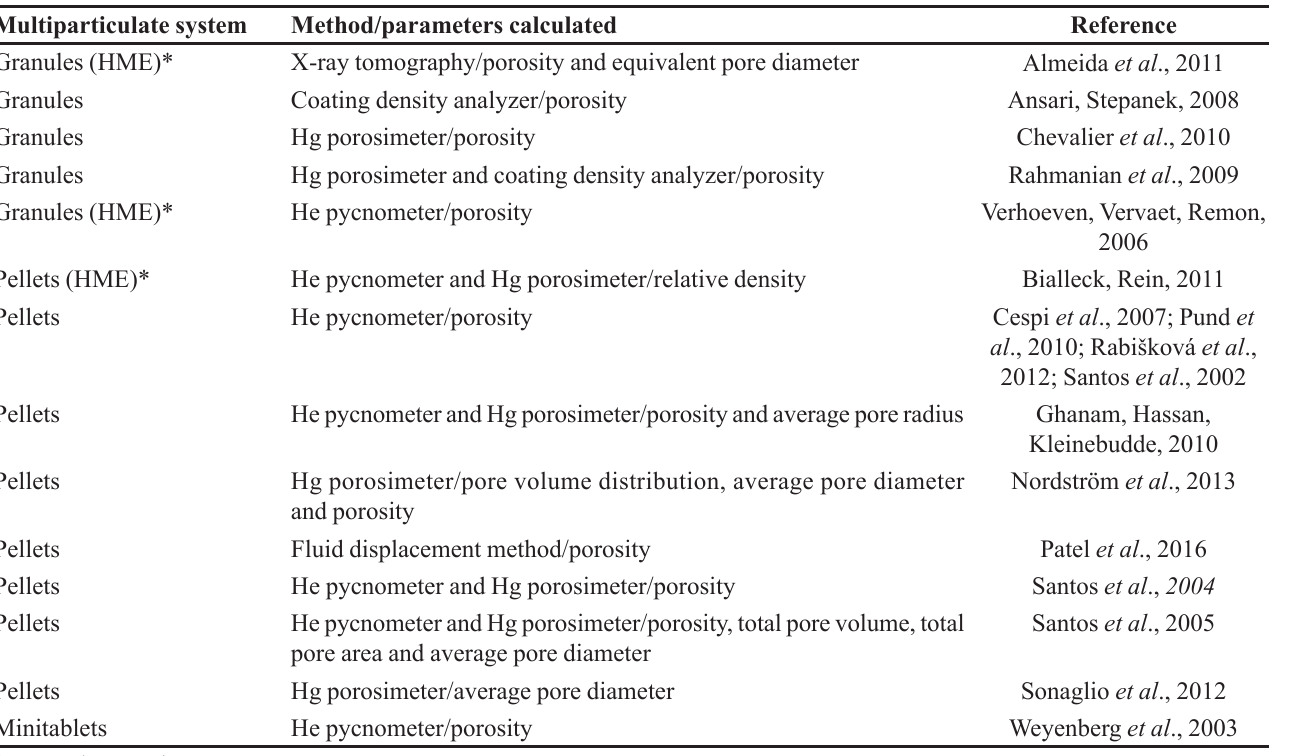
TABLE VII – Example methods used to determine the porosity of multiparticulate systems Multiparticulate